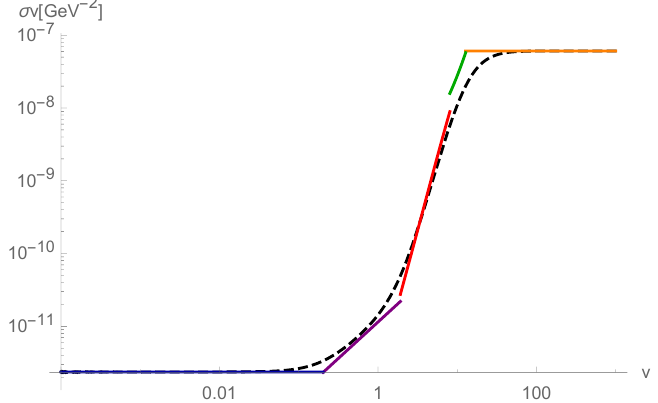
= 10 MeV, m = 5 m and δ = 10 − 2 MeV. The dashed black A 0 χ l l